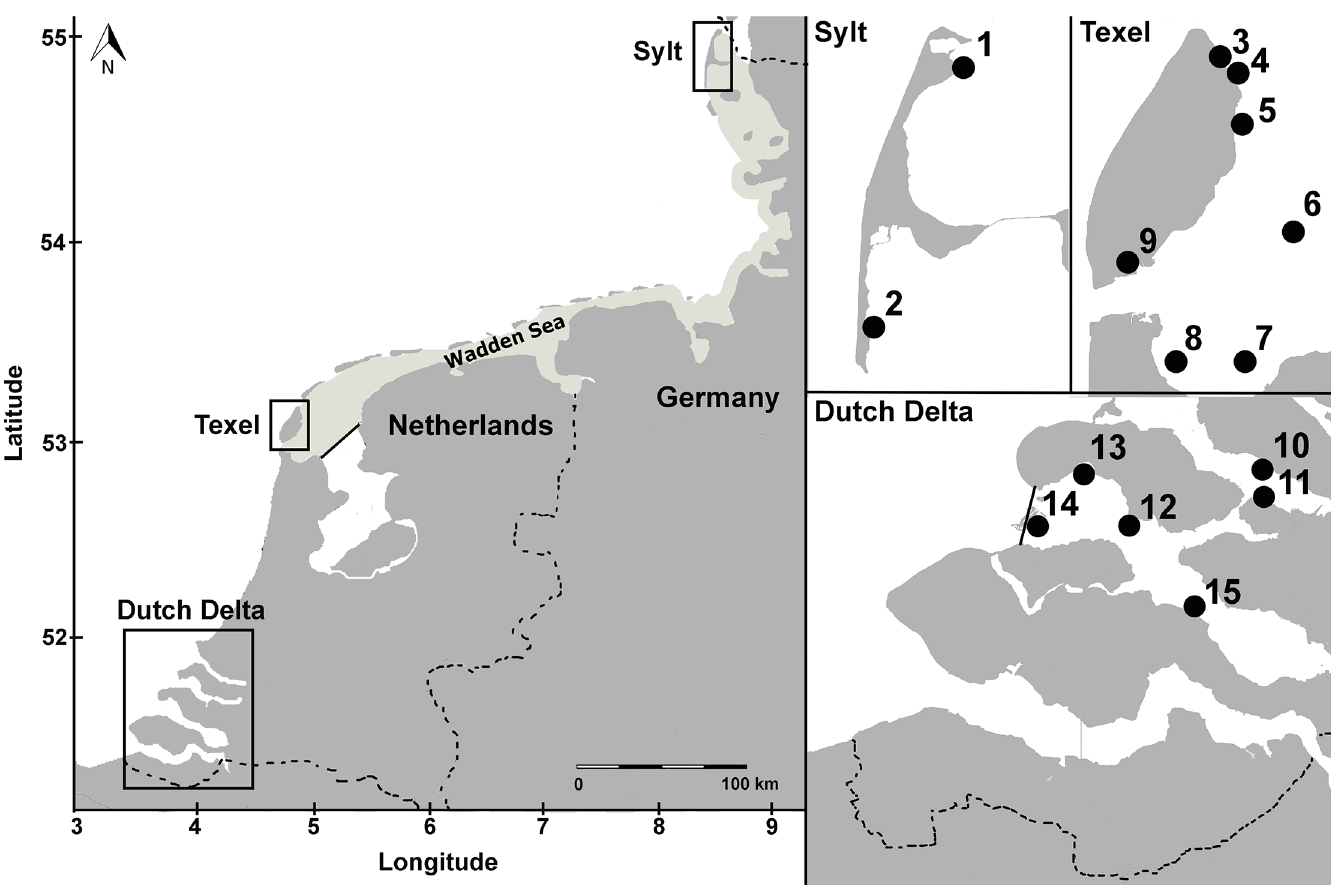
Fig 1. Sampling locations of blue mussel ( Mytilusedulis )and Pacific oyster ( Magallana (previously Crassostrea ) gigas )hosts. Left: The sampled regions in the Dutch Delta and the Wadden Sea (shaded area), with the islands Sylt (north) and Texel (south). Above right: Sampling locations around the islands of Sylt and Texel in the Wadden Sea. Below right: Sampling locations in the Dutch Delta. For exact coordinates see S1 Table.